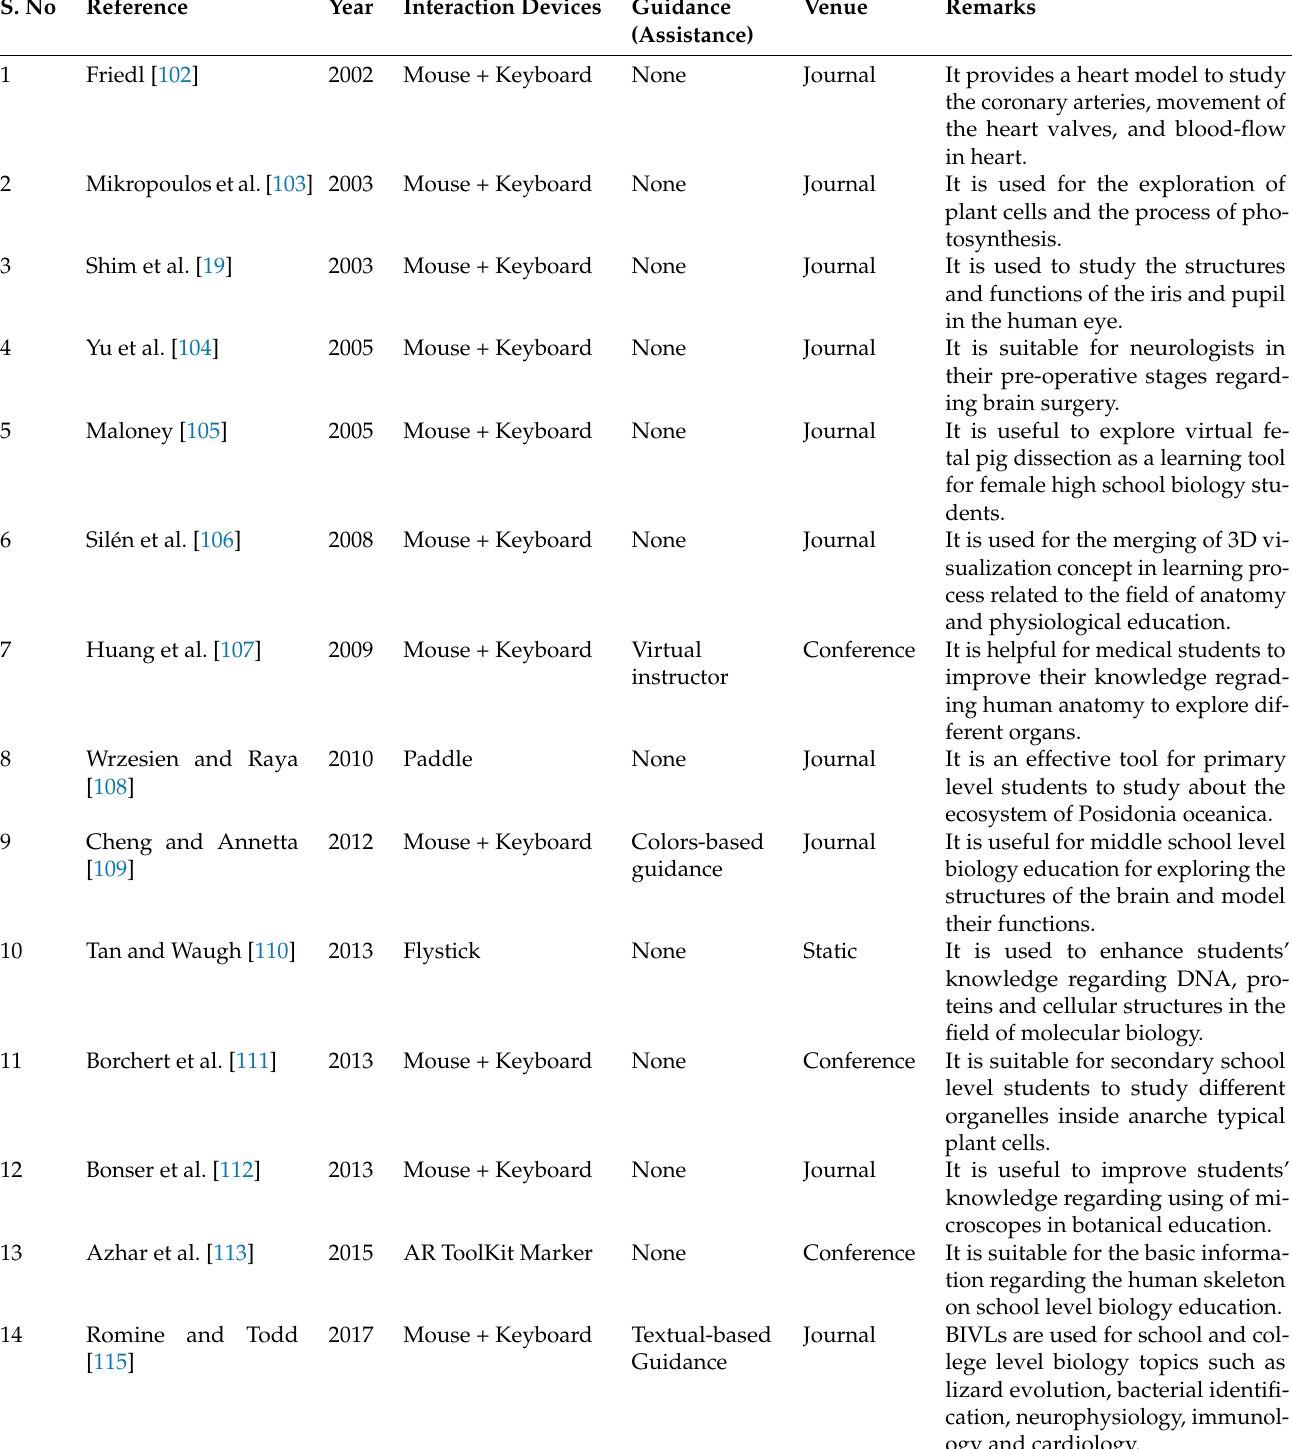
Table 4. Analysis of the existing Interactive Biological Laboratories in